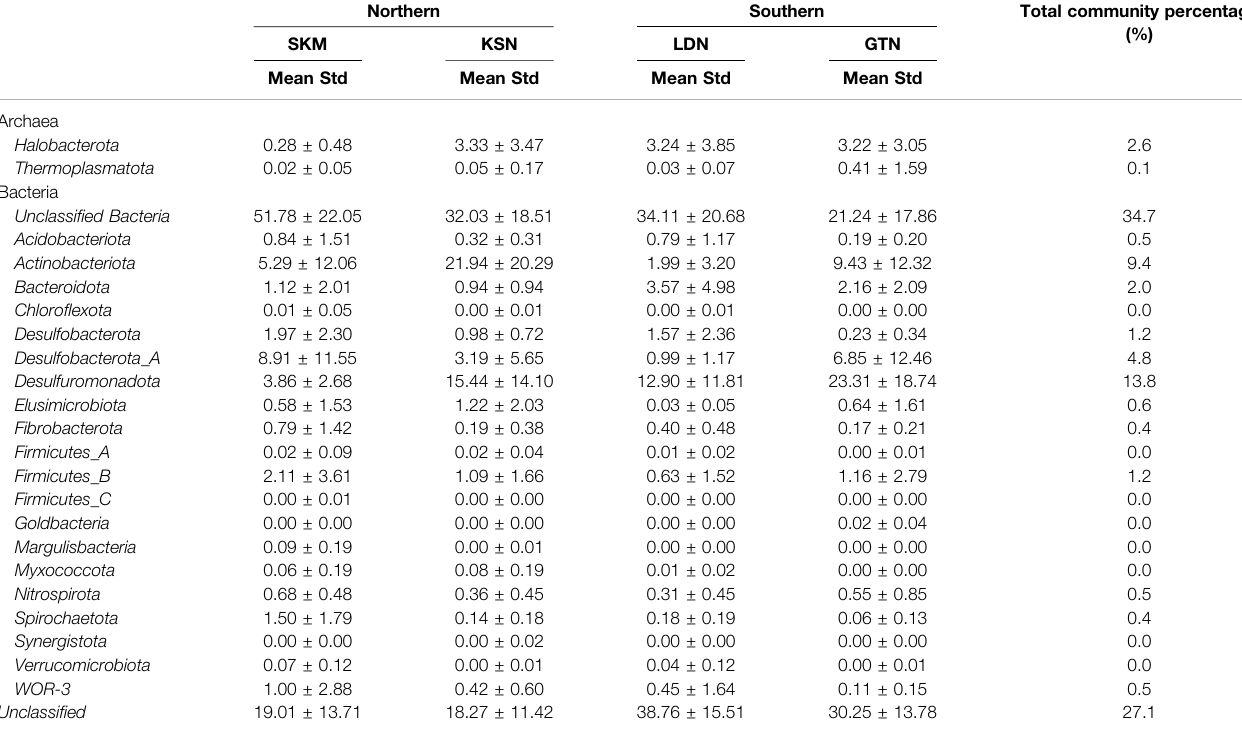
TABLE 1 | Relative hgcA sequence abundances (%) at levels of phyla for the combined 81-sample data set that includes all four